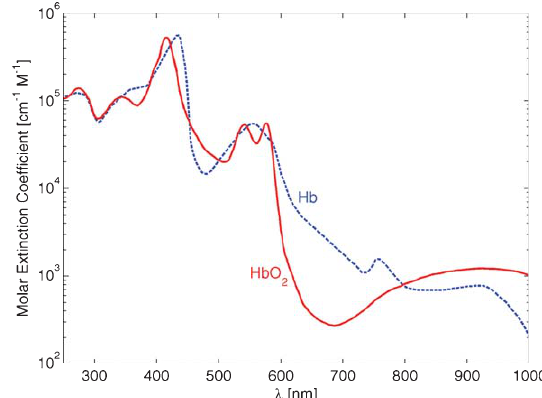
Fig. 1. Extinction coefficents (absortivities) of oxyhemoglobin (HbO 2 ) and deoxyhemoglobin (Hb). Data from